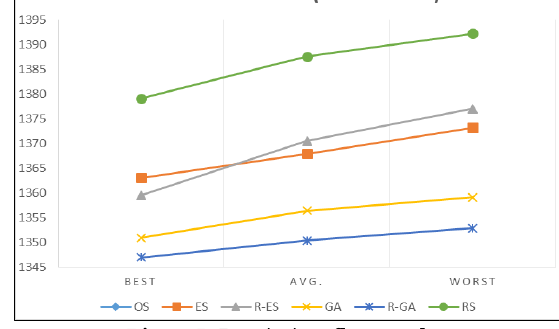
Figure 4. Third shop floor results.